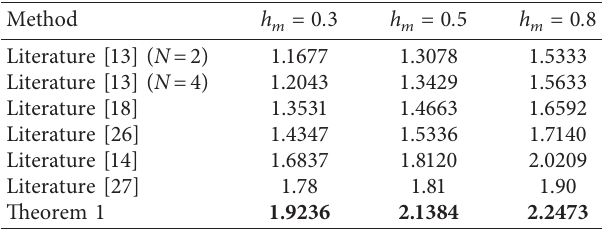
Table 2: In Example 1, when μ � any , MADB is simulated to be obtained for different h m and different methods.